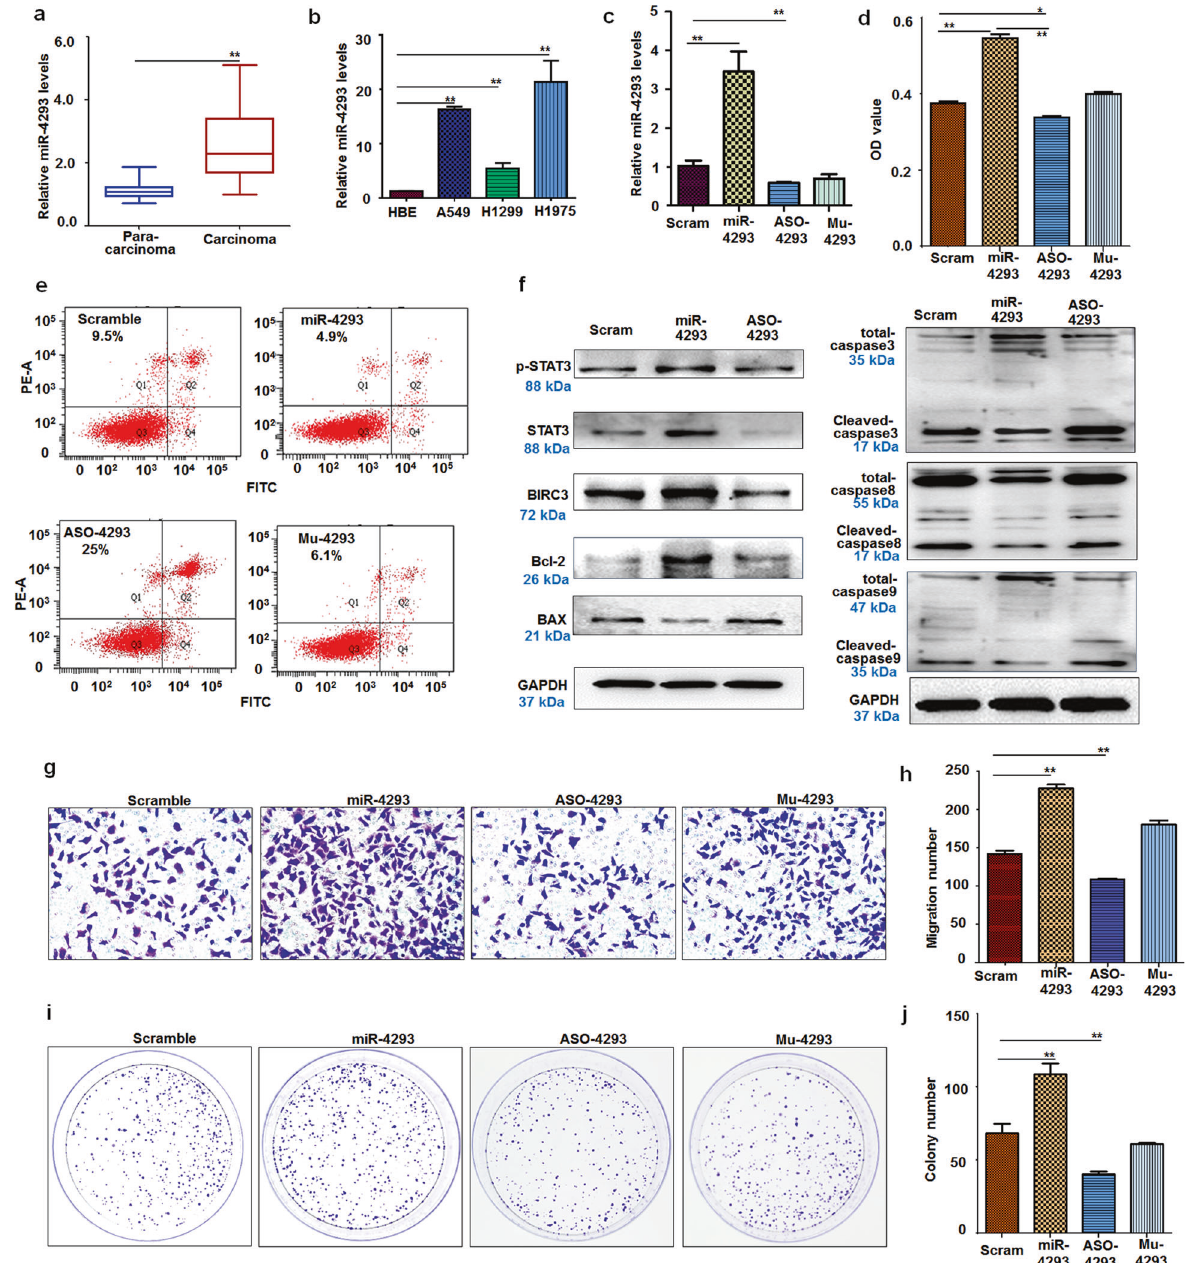
Fig. 1 miR-4293 regulates lung cancer cell proliferation, migration, and apoptosis. a qRT-PCR analysis of miR-4293 levels in NSCLC tissues and corresponding para-carcinoma tissues ( n = 16). Data are expressed as median (interquartile range). **P < 0.01; Mann – Whitney U test. b qRT-PCR analysis of miR-4293 levels in A549, H1299, H1975, and HBE cells. Data are expressed as mean ± SD for triplicate experiments. ** p < 0.01; ANOVA test. c qRT-PCR analysis of miR-4293 level in A549 cells with transfection of miR-4293 mimic, ASO-4293, mu-4293 (mutant), or scrambled. Data are expressed as mean ± SD for triplicate experiments. ** p < 0.01; ANOVA test. d MTT assay of A549 at 24 h post-transfection of miR-4293, ASO-4293, mu-4293 or scrambled. Data are expressed as mean ± SD for triplicate experiments. ** p < 0.01, * p < 0.05; ANOVA test. e FACS analysis of A549 cell apoptosis at 24 h post-transfection of miR-4293, ASO-4293, mu-4293, or scrambled. f Western blot detection of STAT3 and apoptosis-related factors (Bcl-2, Bax, BIRC3, and Caspase 3,8,9) in miR-4293-, ASO-4293-, or scramble-treated A549 cells. g , h Transwell migration assay of A549 at 24 h post-transfection of miR-4293, ASO-4293, mu-4293, or scrambled. Data are expressed as mean ± SD for triplicate experiments. ** p < 0.01; ANOVA test. i , j Colony formation assays of A549 at 24 h post-transfection of miR-4293, ASO-4293, mu- 4293, or scrambled. Data are expressed as mean ± SD for triplicate experiments. ** p < 0.01; ANOVA plasmid (pcDNA-DCP2) was constructed and transfected into the phosphorylation compared with scrambled control treatment. A549 cells, then the expression of WFDC21P was detected over a STAT3 phosphorylation was also higher in cells co-transfected with time course. As a result, there was no major change in the si-DCP2 and pcDNA-WFDC21P compared with control treatment expression of WFDC21P during pcDNA-DCP2 transfection 0 – 4 h. (Fig. 2g). To investigate the underlying mechanisms that DCP2 Interestingly, the expression of WFDC21P was signi fi cantly downregulated the expression of WFDC21P, DCP2 overexpression